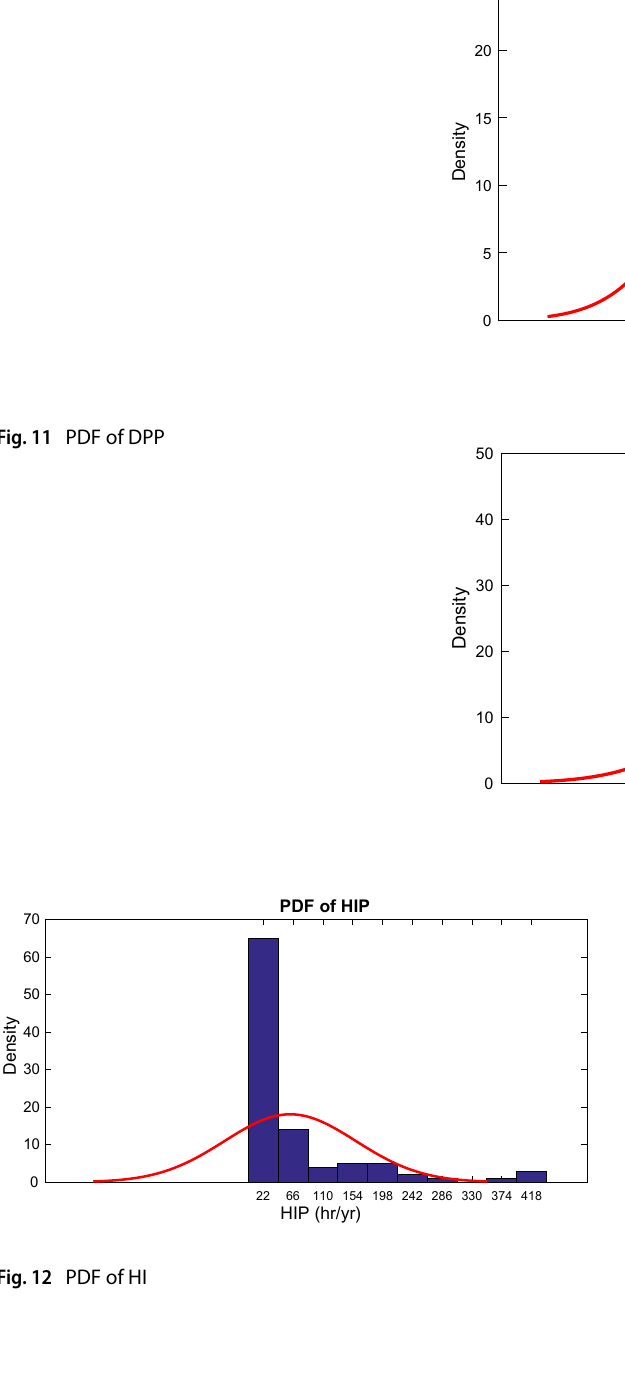
Table 5 Comparison results of deterministic and probabilistic design of hybrid PV/WT/Batt system Parameters N WG N PV N Bat P Inv ( kW ) 𝜃 PV ( deg ) h Tower ( m ) DPP ( MW ∕ yr )